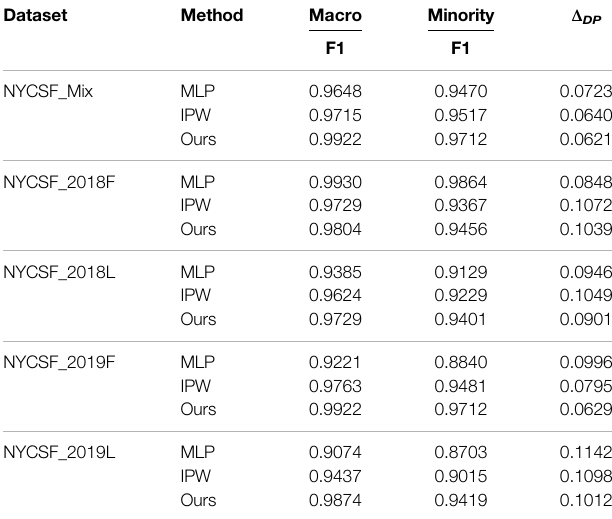
TABLE 2 | Ours VS Inverse propensity score